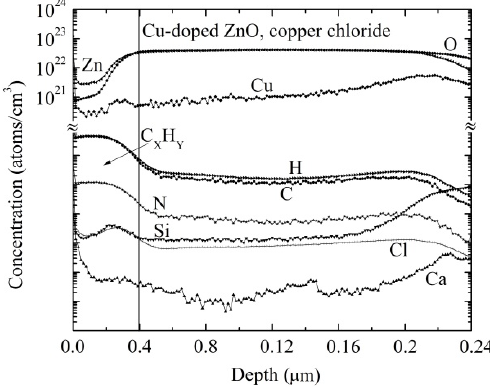
Figure 8. SIMS depth profiles for the Cu ‐ doped ZnO film obtained from six dips in copper chloride and tested for propane sensing.